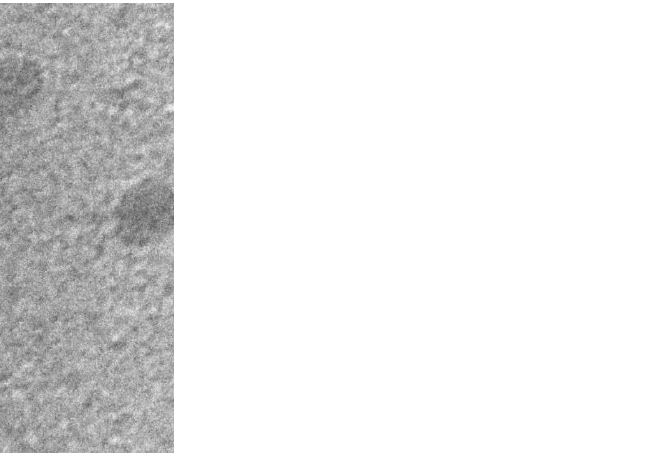
Figure 12. TEM image of Object 1 as a spherical cluster. The lattice parameter is 3.2 Å , and the cluster size is 20 nm.